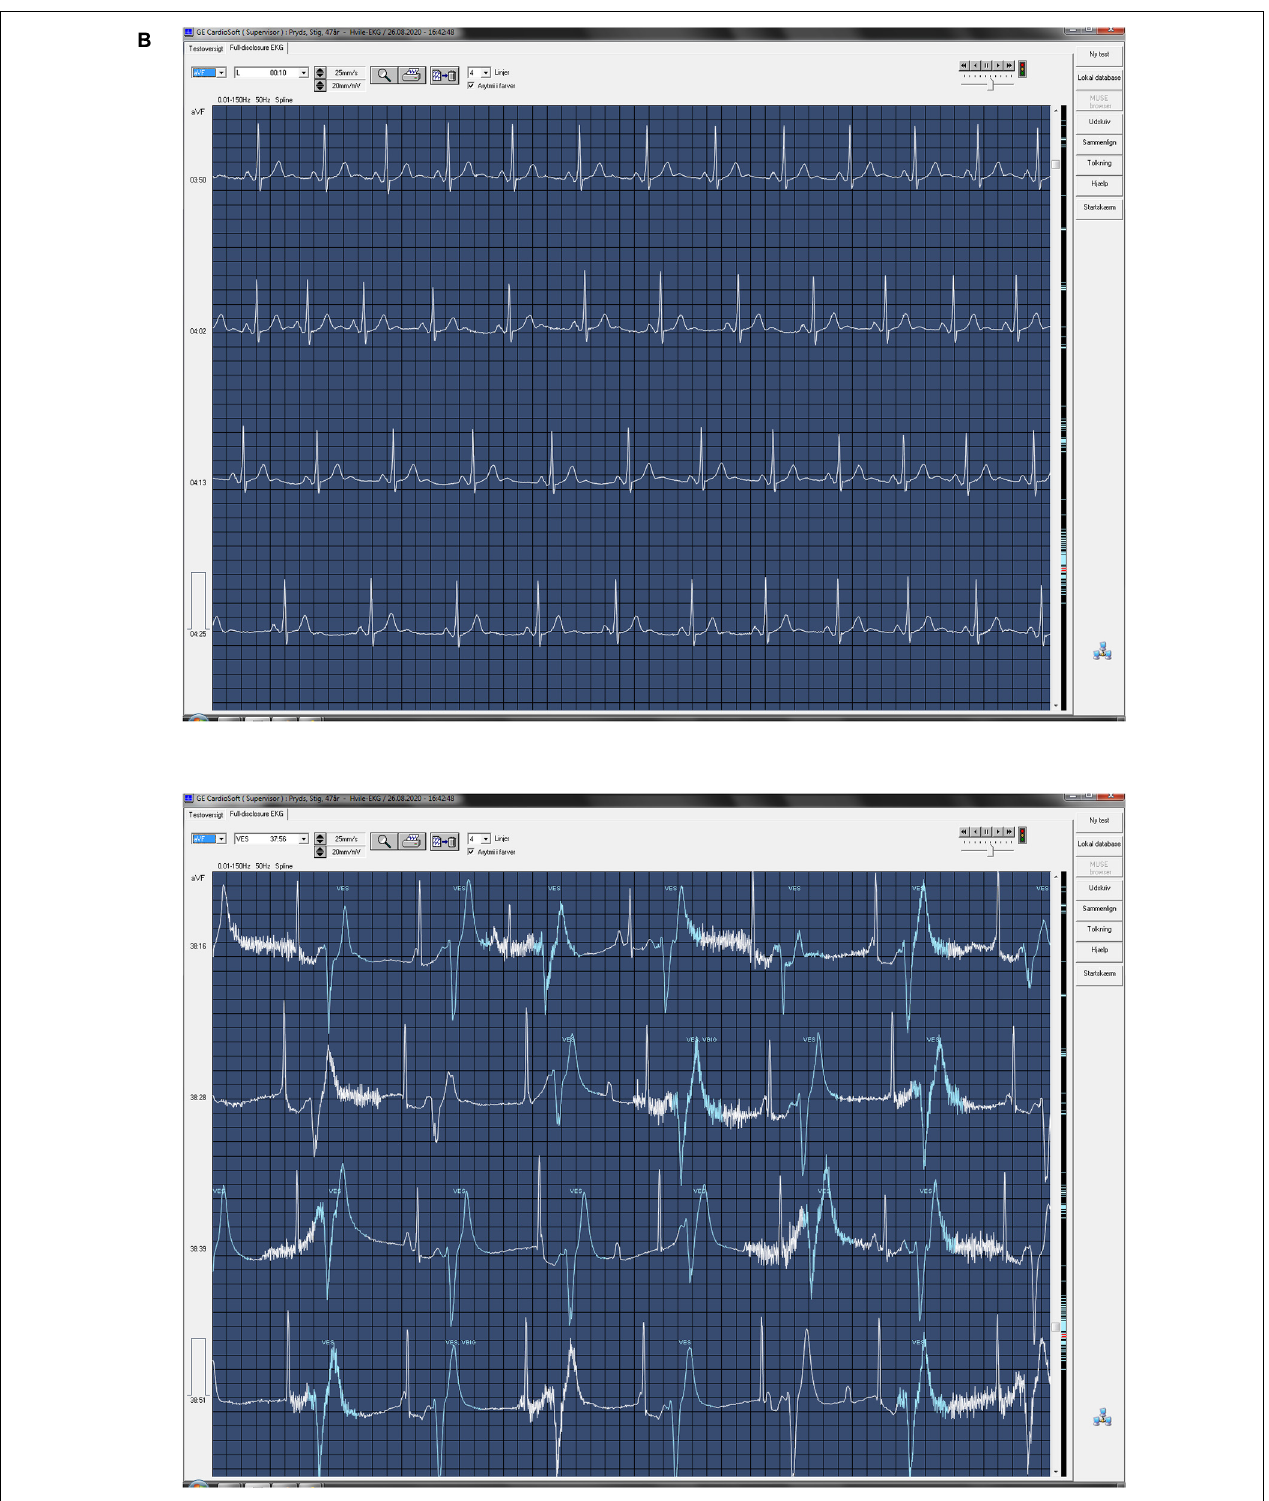
FIGURE 7 | (B) Sinus rhythm at rest (top) and second-degree atrioventricular dissociation during maximum dry apnea (bottom). Recorded at 25 mm/s.